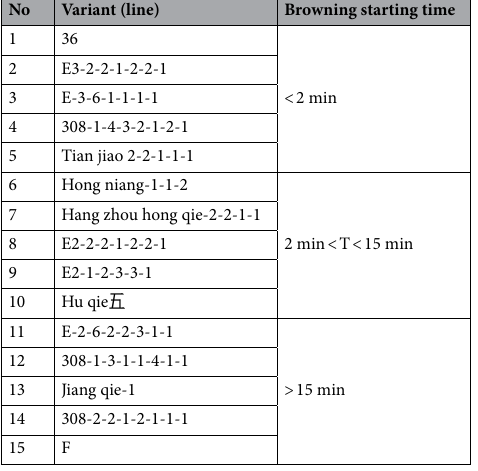
Table 2. The 15 eggplant variants (lines) selected from preliminary